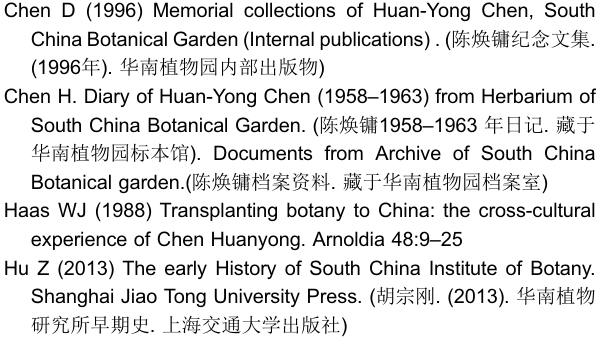
Figure 6. Prof. Huan-Yong Chen worked with Soviet Russia Academicians in